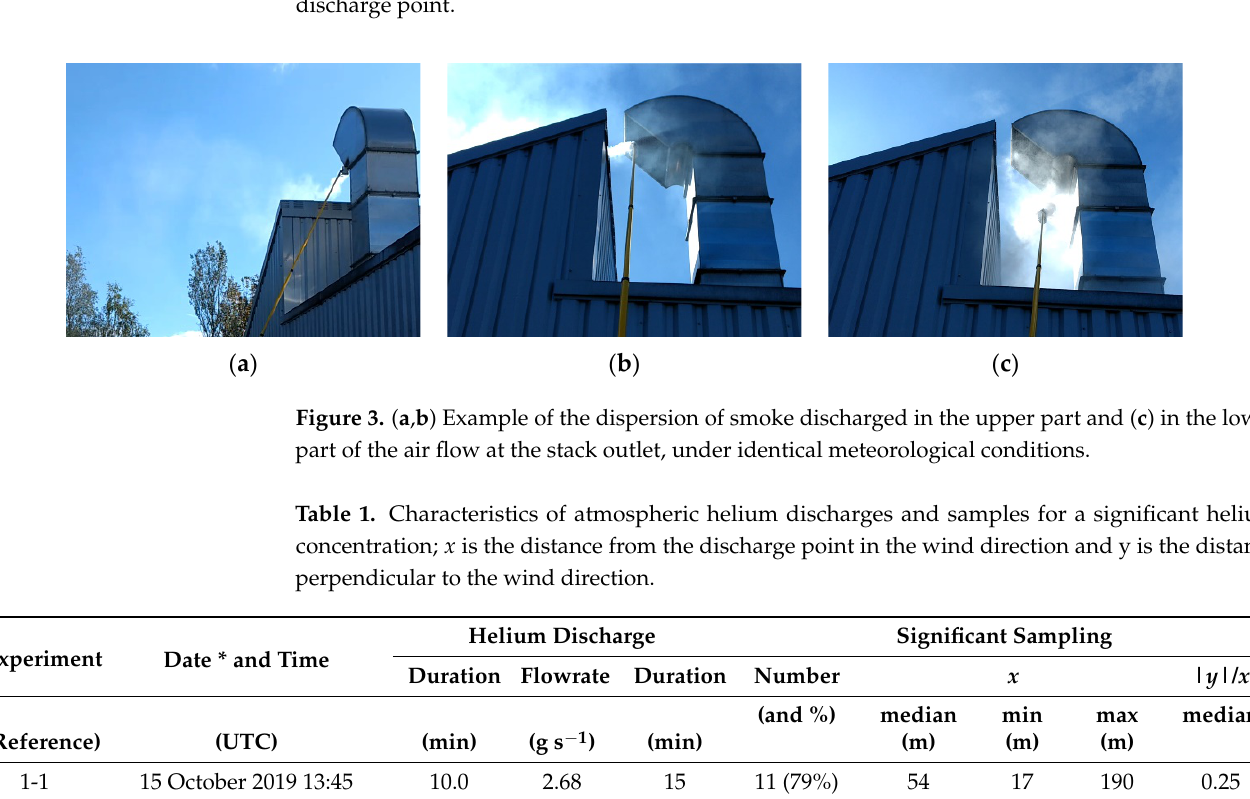
perpendicular to the wind direction. 𝐴𝐴